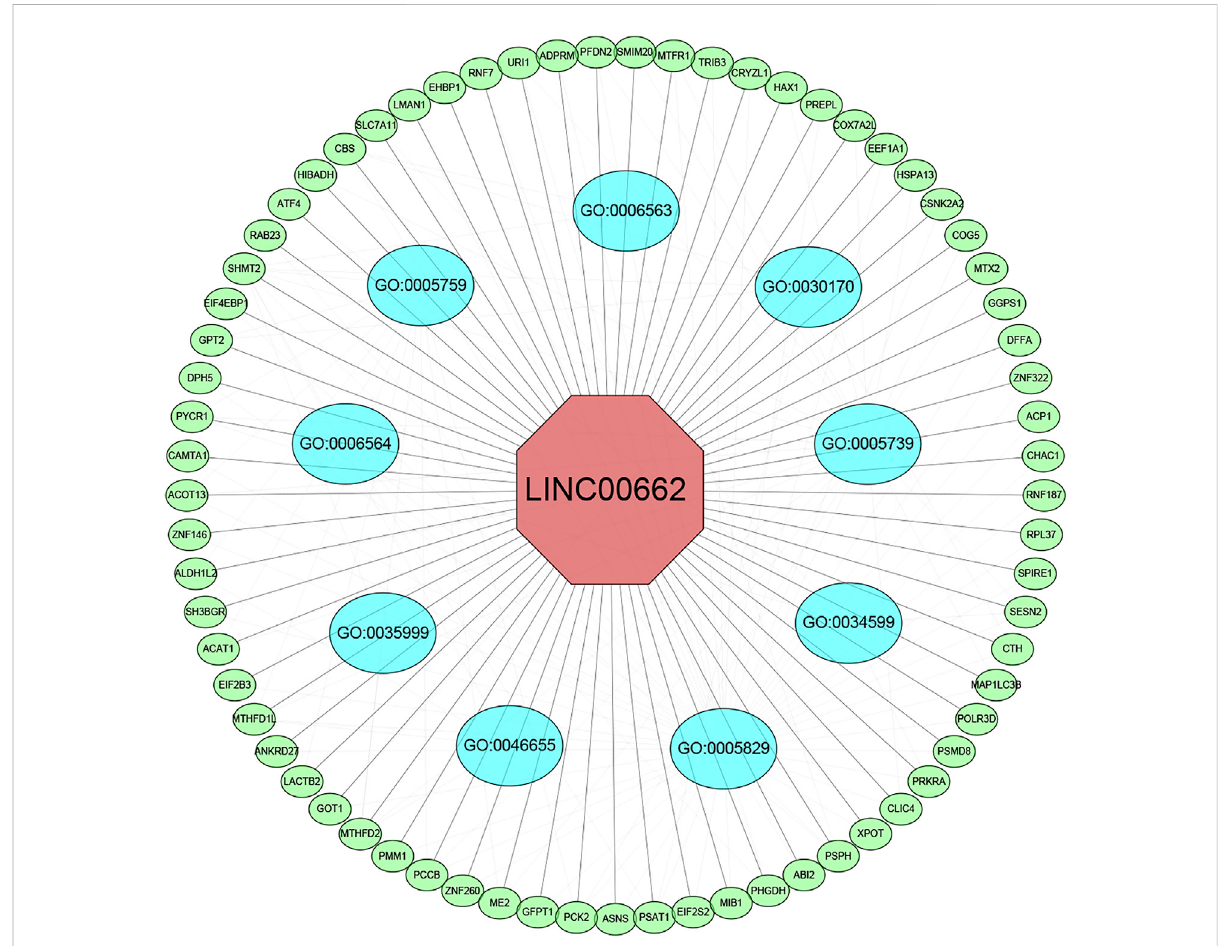
FIGURE 8 LINC00662-relatedgenesinteractionnetwork analysis.Greennodesrepresenttargetgenesandskybluenodesrepresenttherelatedpathway. As indicated in red, LINC00662 localized at the center of the network. GO:0005759 (mitochondrial matrix); GO:0006563 (L-serine metabolic process); GO:0030170 (pyridoxal phosphate binding); GO:0005739 (mitochondrion); GO:0034599 (cellular response to oxidative stress); GO: 0005829 (cytosol); GO:0046655 (folic acid metabolic process); GO:0035999 (tetrahydrofolate interconversion); GO:0006564 (L-serine biosynthetic